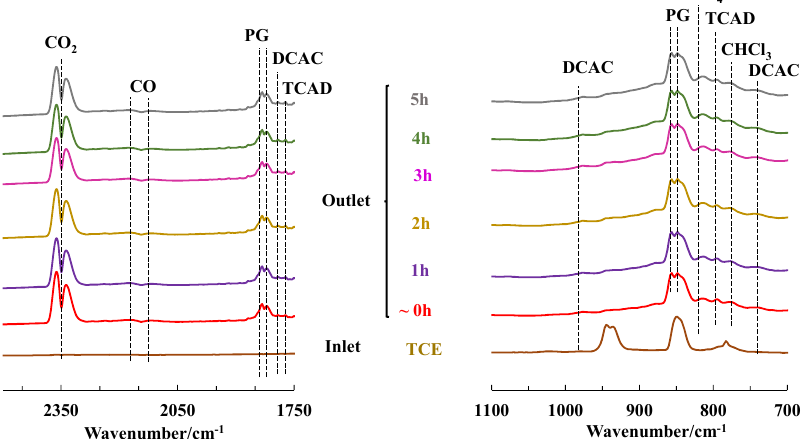
Figure 12. FT-IR spectra of the inlet TCE and outlet gaseous stream after the PPC process (RH = 15%) with Ce 0.01 Mn-AT as the catalyst as a function of time. PG: phosgene; DCAC: dichloroacetylchloride; TCAD: trichloroacetaldehyde.